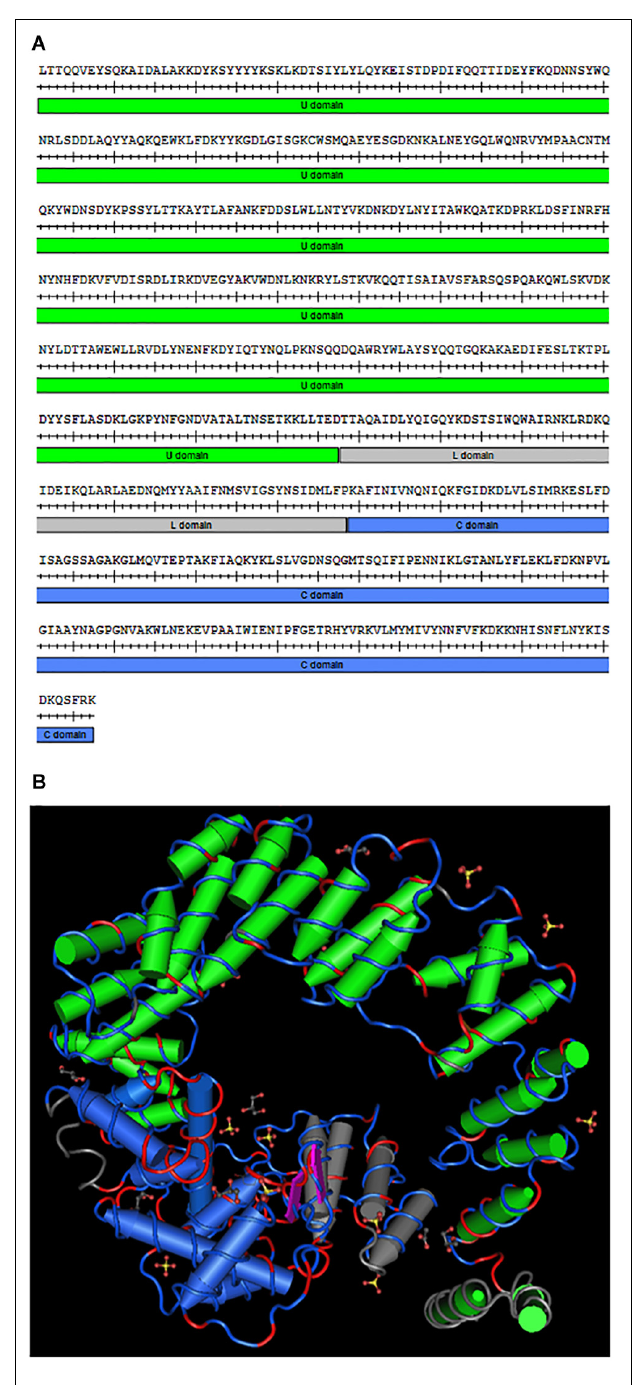
FIGURE 1 | Francisella novicida Slt homology model. (A) Amino acid sequence of the mature F. novicida Slt protein; U domain, linker (L) domain, and catalytic (C) domain are annotated in green, gray, and blue, respectively. (B) Homology model of F. novicida Slt onto the structure of Slt70 from E. coli . U, L, and C domains are color-coded according to sequence shown in (A) . Model was generated using Cn3D software v4.3.1 based on alignment of F. novicida Slt with the crystal structure of Slt70 from E. coli (PDB accession 1QSA). The helix cylinders are color-coded according to the domains shown in (A) . The amino acid backbone is rendered according to identity; identical residues in red and dissimilar residues in